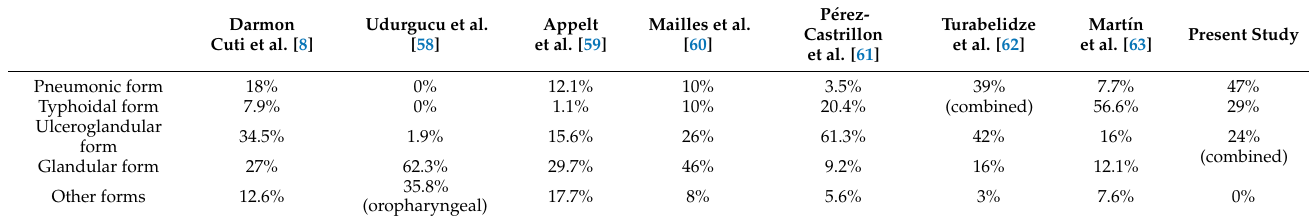
Table 2. Comparison of the clinical presentations of tularemia in different